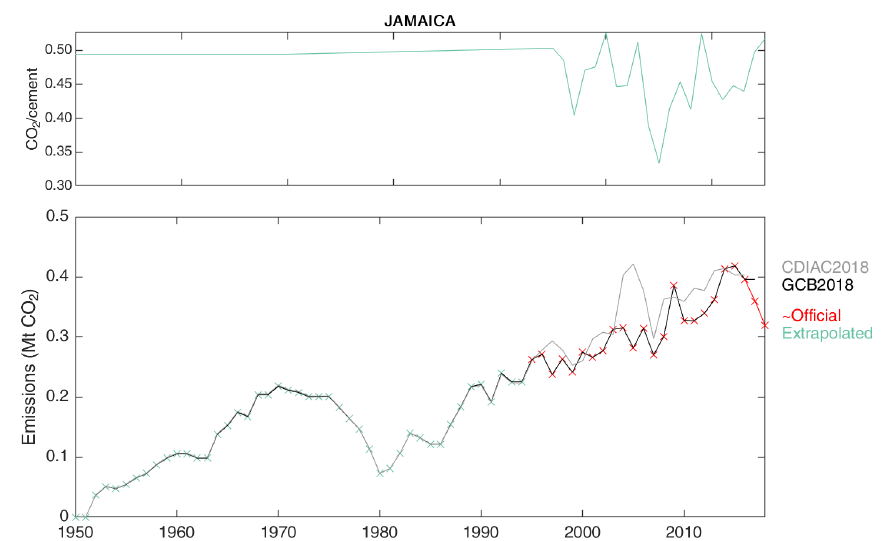
Figure C24. Revised cement emissions for